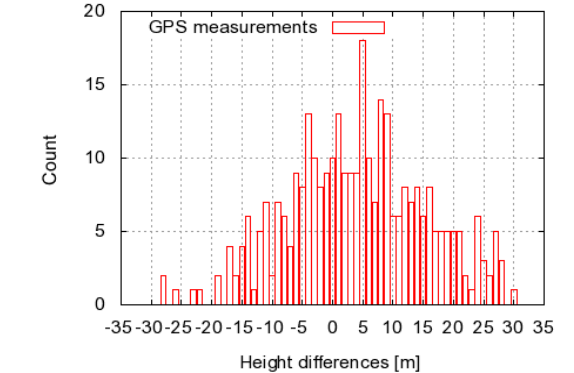
Figure 5. Comparison of heights between ground-based GPS measurements and SRTM-3 (red: continuous measurement in 2010; green: CPs in 2010; and blue: CPs in 2011).